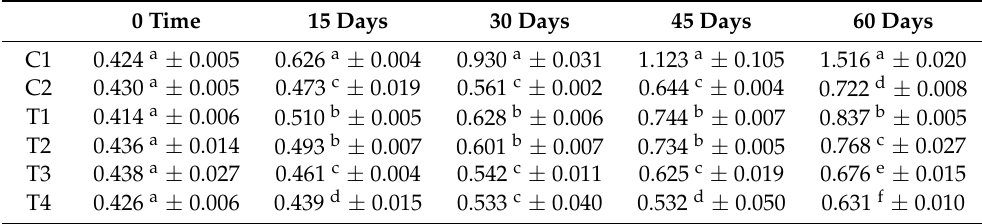
Table 9. TBARS values (mg MAD kg − 1 sample) of mayonnaise samples enriched with RCFE during storage. 0